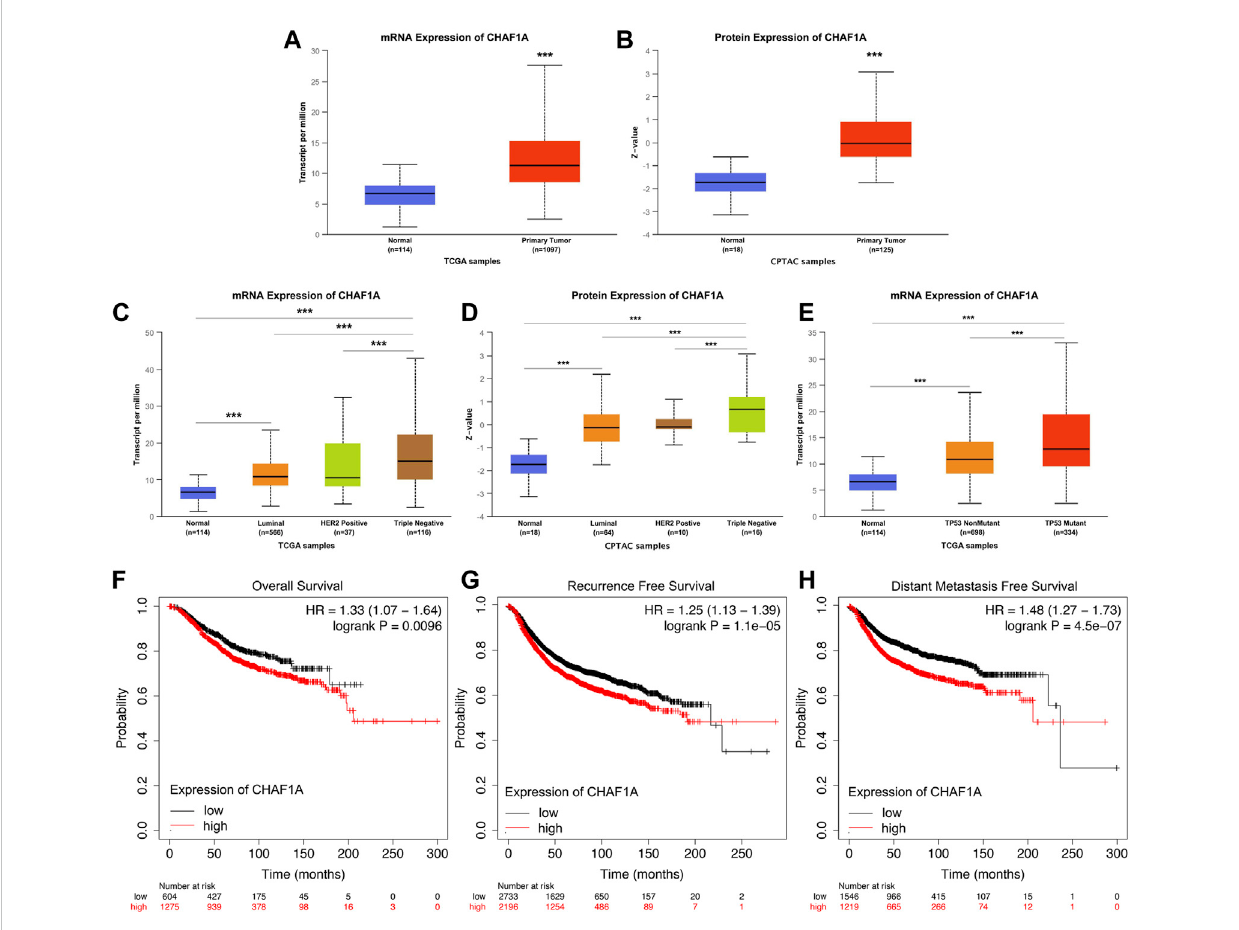
FIGURE 2 ElevatedexpressionofCHAF1Ainbreastcancertissueswassigni fi cantlycorrelatedwithbreastcancerpatients ’ poorprognosis.ByapplyingUALCAN database (A,B) Both mRNA expression and protein expression of CHAF1A were dramatically increased in breast cancer tissues. (C,D) CHAF1A was overexpressed in all subtypes of breast cancer samples compared with normal ones. And compared with either Luminal or HER2 positive breast cancers, CHAF1AshowedthehighestexpressioninTNBC. (E) TheexpressionofCHAF1AwashigherinTP53mutantbreastcancertissuescomparedtoeither TP53wildtypeornormaltissues(***: p < 0.001).InKaplan-MeierPlottersurvivalanalysis. (F) ThebreastcancerpatientswithhigherexpressionofCHAF1A showed poor overall survival (OS)comparedto patients with lower CHAF1A expression. (G) The breastcancer patients with higher expression ofCHAF1A took less time to develop disease recurrence. (H) The breast cancer patients with higher CHAF1A expression took shorter time to develop cancer distant